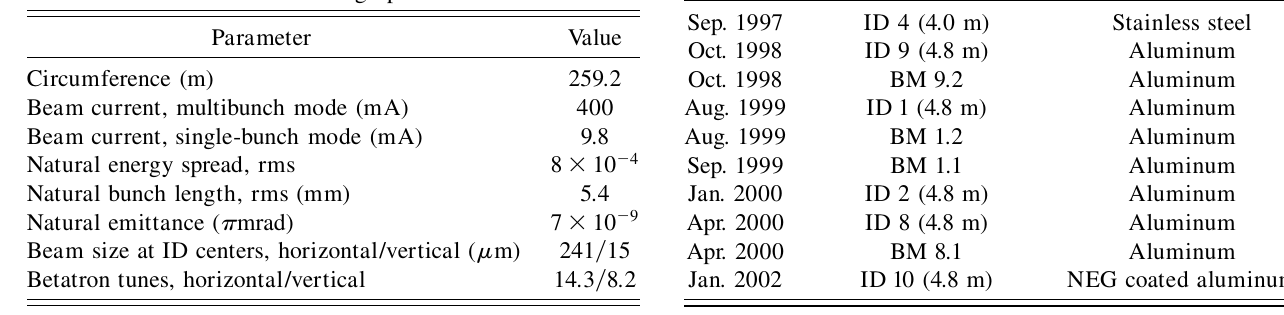
TABLE I. ELETTRA design parameters at 2 CeV.